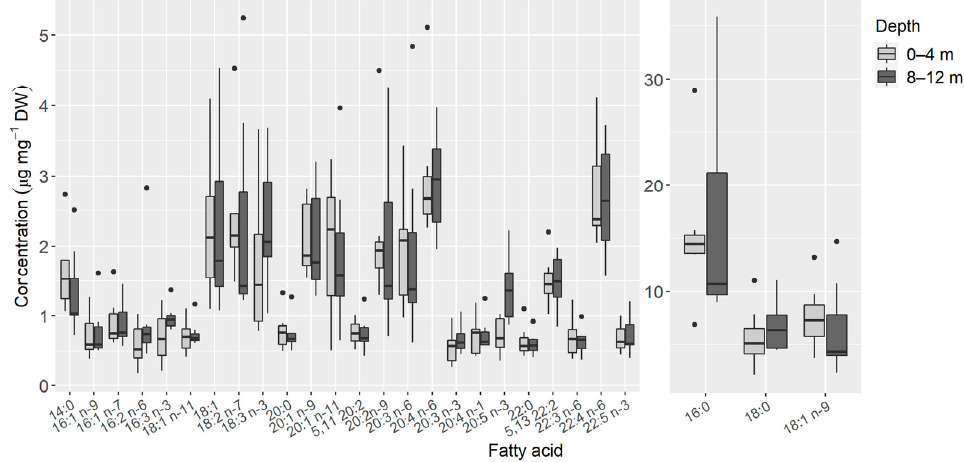
Figure 6. Fatty acid (FA) concentrations from samples of Elysia crispata collected at 0–4 m ( n = 7) and 8–12 m ( n = 7) depths, in the Southern Gulf of Mexico. The line represents the median, top and bottom of the box are the 25th and 75th percentiles. The whiskers represent the maximum and minimum values, and dots are outliers.